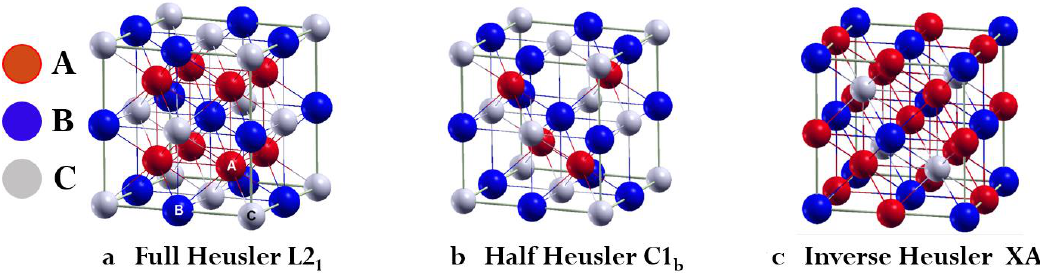
Figure 1. Crystal cell of ( a ) a full Heusler structure, ( b ) half Heusler structure, and ( c ) inverse Heusler structure.